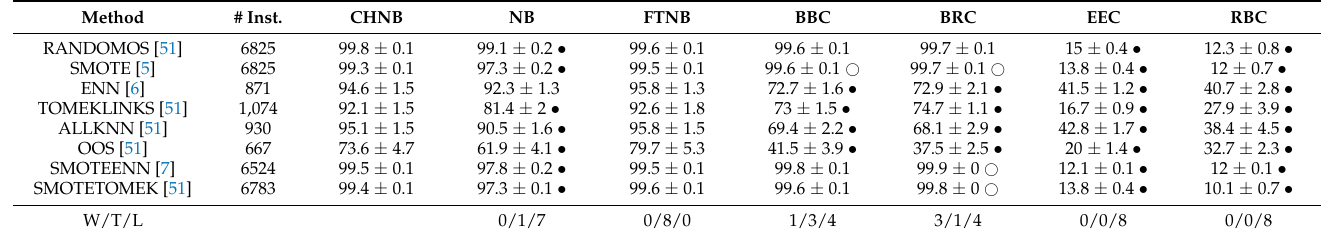
Table 5. Macro F-score for the classifiers combined with different resampling methods on the CIC’17 dataset.